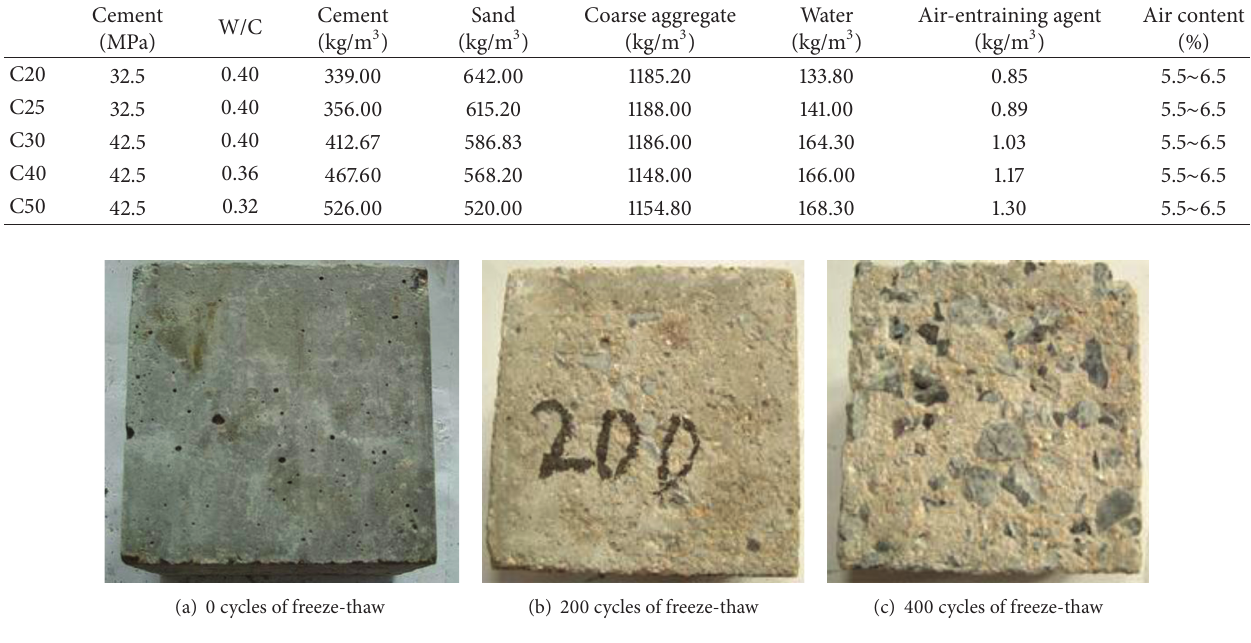
Figure 1: Surface of C30 air-entrained concrete after 0, 200, and 400 cycles of freeze-thaw.